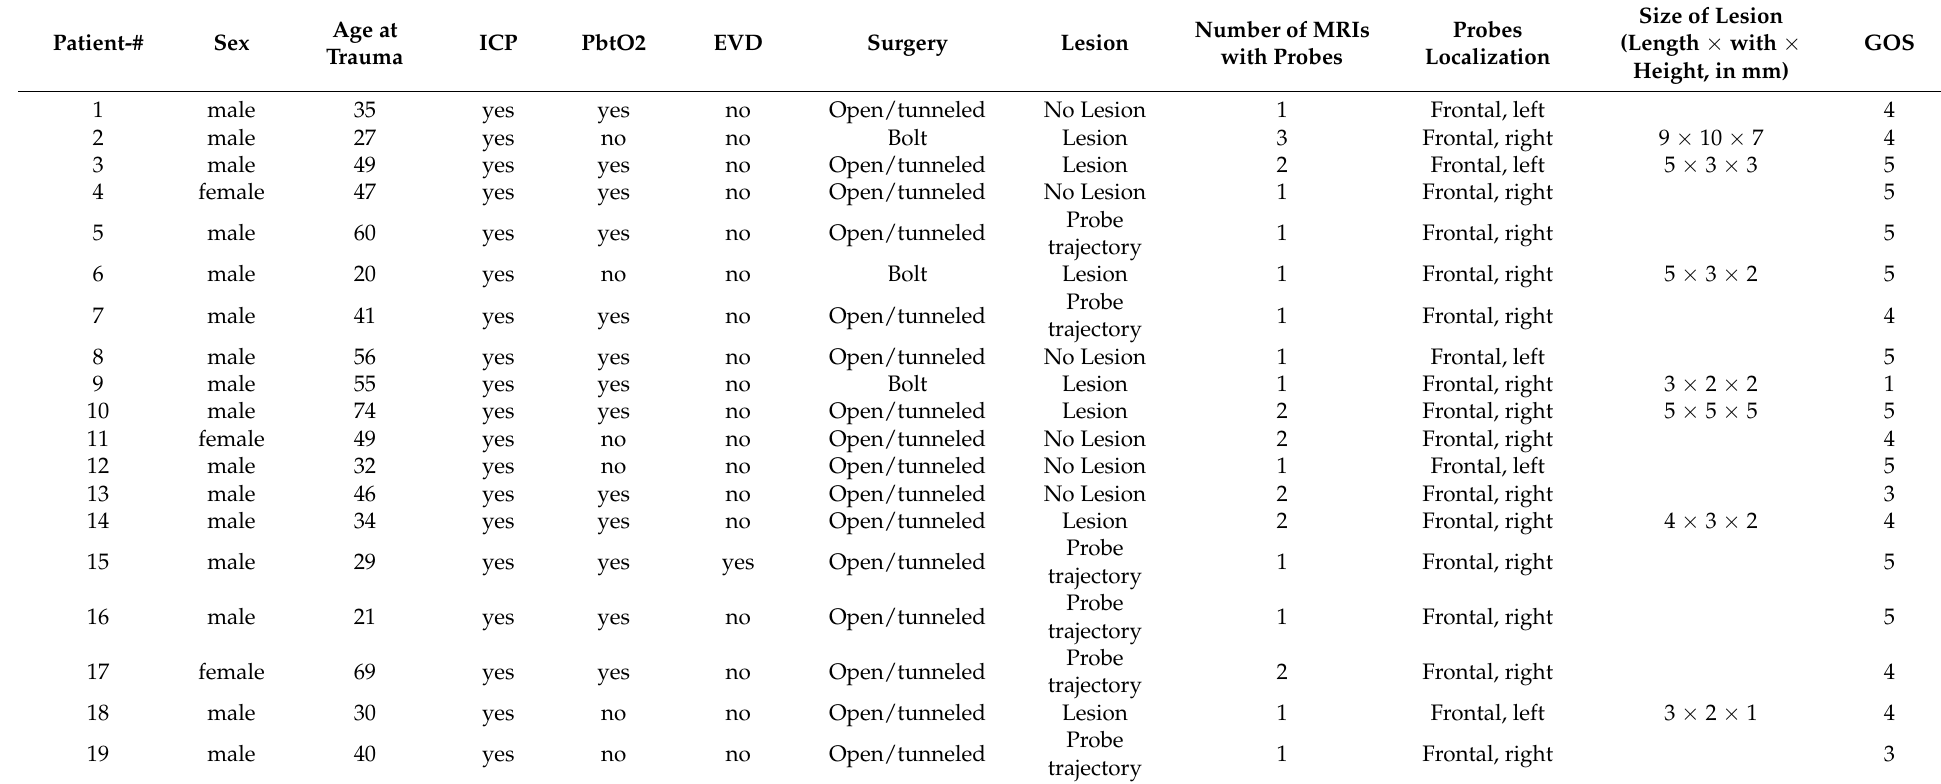
Table 1. Demographics of study cohort including age, gender, kind of probes implanted, kind of surgery, kind of lesion, numbers of MRIs performed, side of probe placement, size of visible lesion in millimeter, and Glasgow Outcome